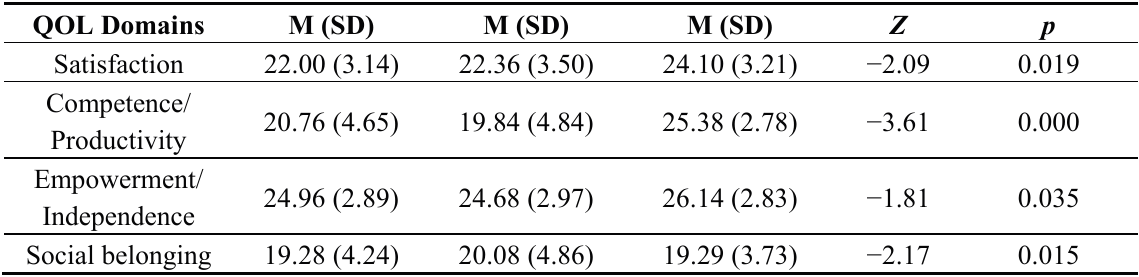
Table 1. Means and standard deviations and Wilcoxon analysis of QOL-Q at three points.